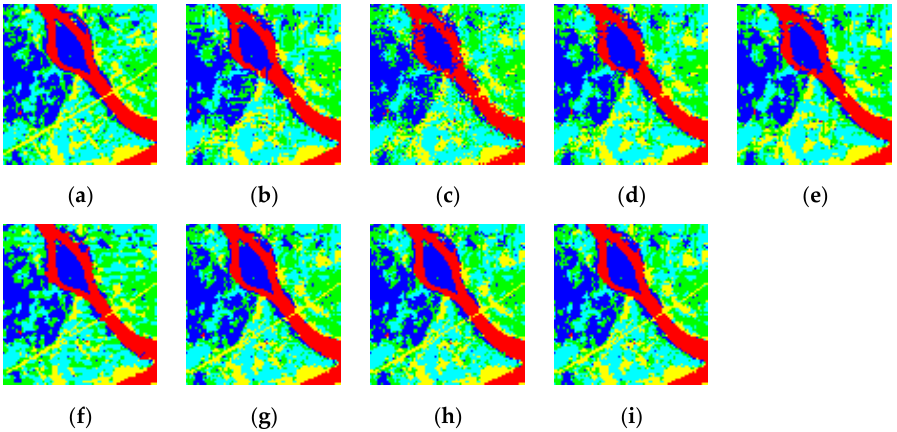
Figure 11. Zoomed areas of each sub-pixel mapping result: ( a ) Zoom of the original classification result of the 2005 Landsat TM image; ( b ) Zoom of the PSSM result; ( c ) Zoom of the GASM result; ( d ) Zoom of the DESM result; ( e ) Zoom of the CSSM result; ( f ) Zoom of the SSMPS result; ( g ) Zoom of the SSMGA result; ( h ) Zoom of the SSMDE result; and ( i ) Zoom of the SSMCS result. Table 1. Comparison of the different algorithms for the Landsat 8 image in Experiment 1. Scale = 4